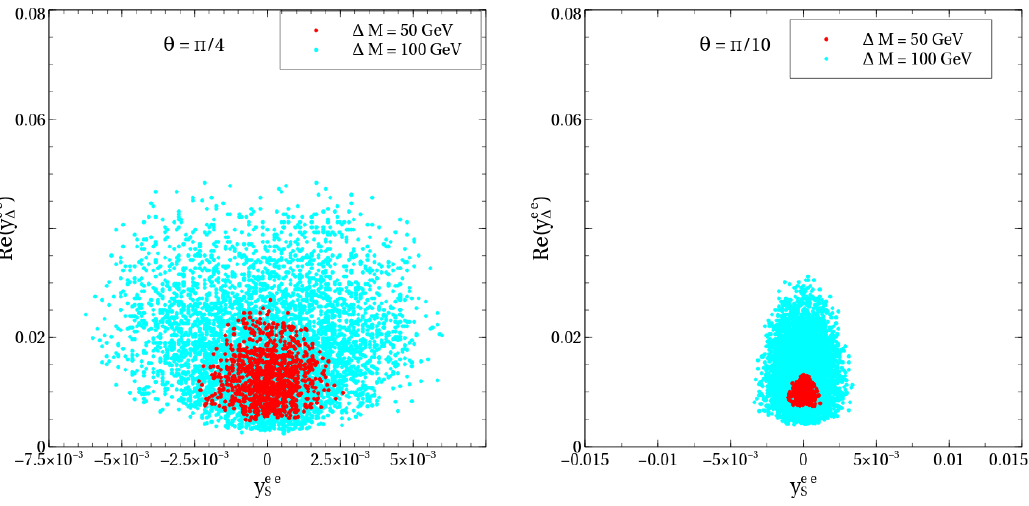
Figure 11 . Scatter points maintaining (cid:1) a (cid:22) within its 2 (cid:27) range and BR (cid:28) ! (cid:22) (cid:22)ee within the quoted limit plotted in the y ee Re( y ee ) plane for (cid:18) = (cid:25) (left) and (cid:25) (right). A normal neutrino mass S (cid:0) (cid:1) 4 10 hierarchy is assumed. The color coding is explained in the